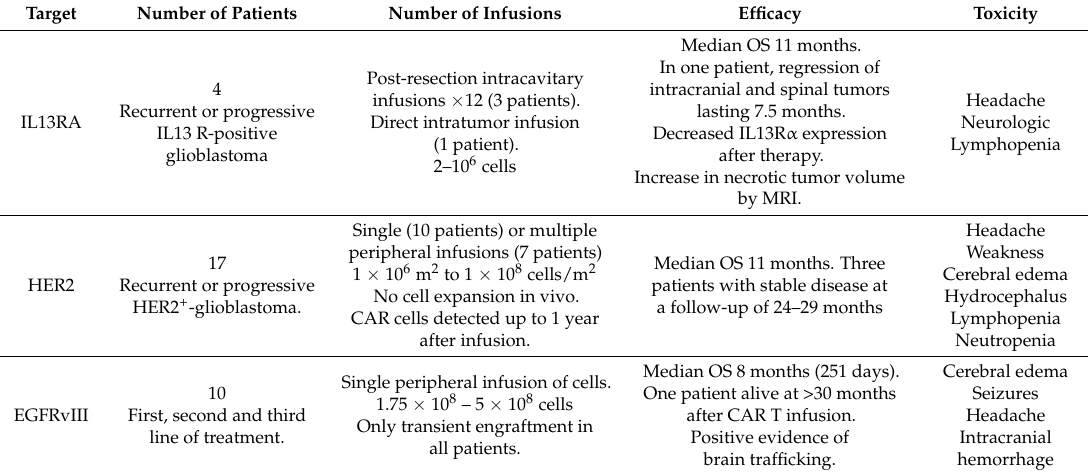
Table 8. CAR T cell trials in